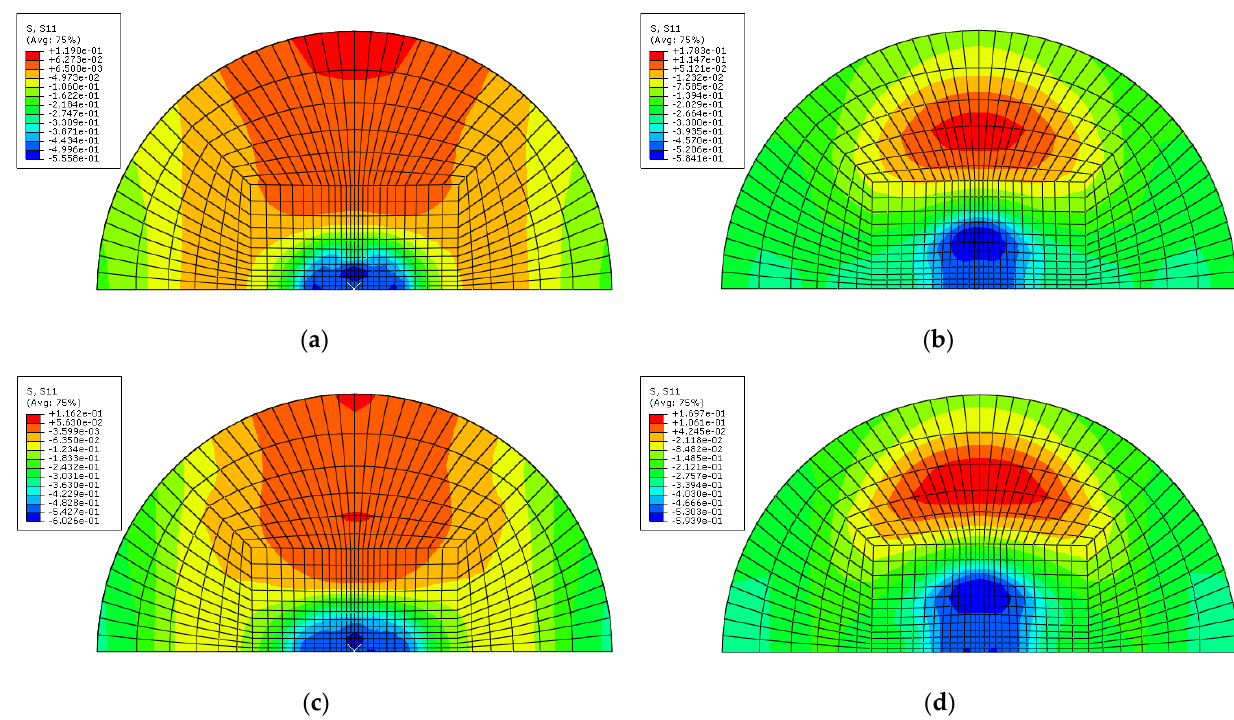
Figure 14. Detection of σ 11 on impacted and non-impacted aluminum layer of GLARE 5-2/1: ( a ) first impact: impacted aluminum layer at 8 J, ( b ) first impact: non-impacted aluminum layer at 8 J, ( c ) second impact: impacted aluminum layer at 8 J and ( d ) second impact: non-impacted aluminum layer at 8 J.